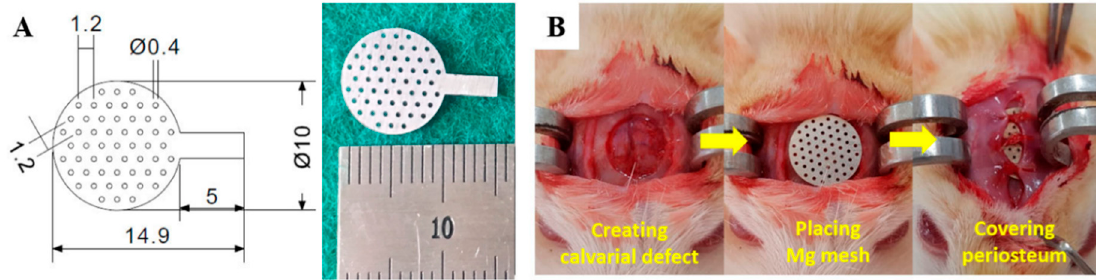
Figure 1. ( A ) Schematic diagram and optical image of the magnesium mesh used for the experiment; ( B ) operative procedure for the rat calvarial defect model.